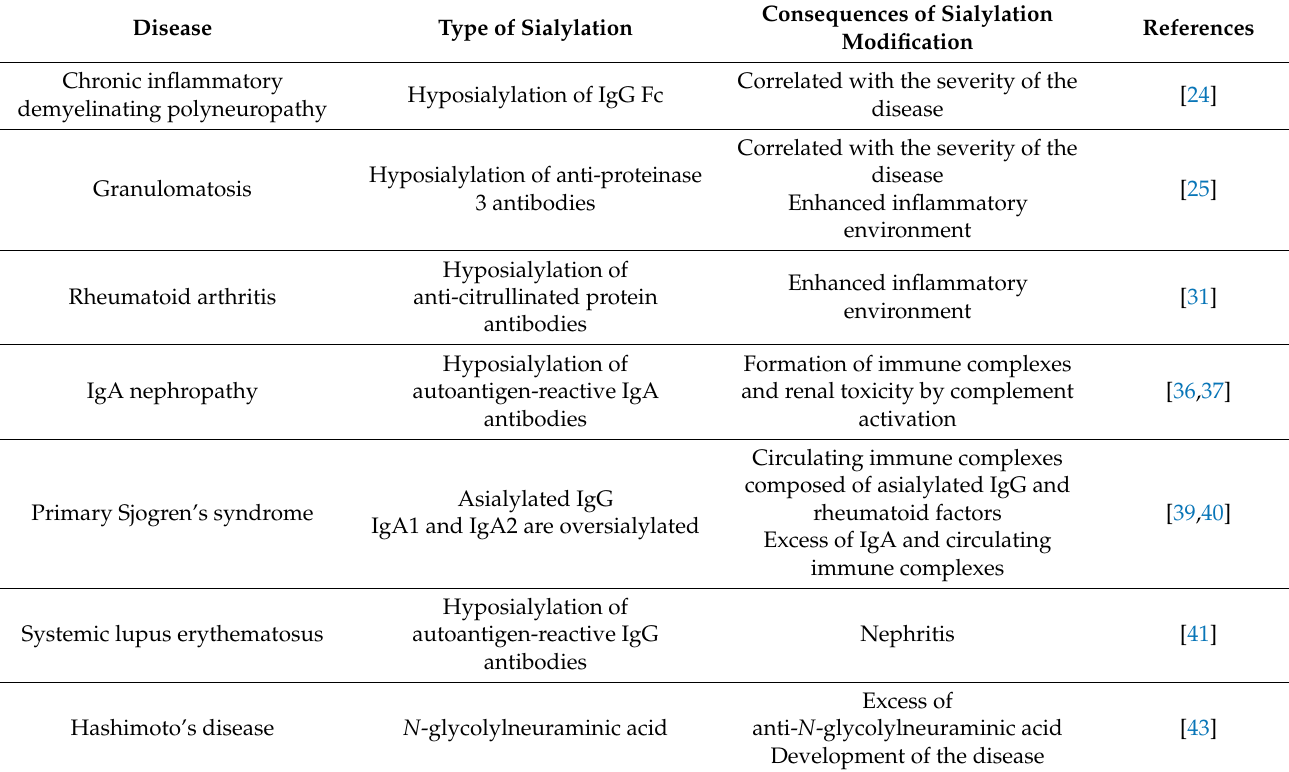
Table 1. Importance of sialic acid modifications in autoimmune diseases and pathological consequences.